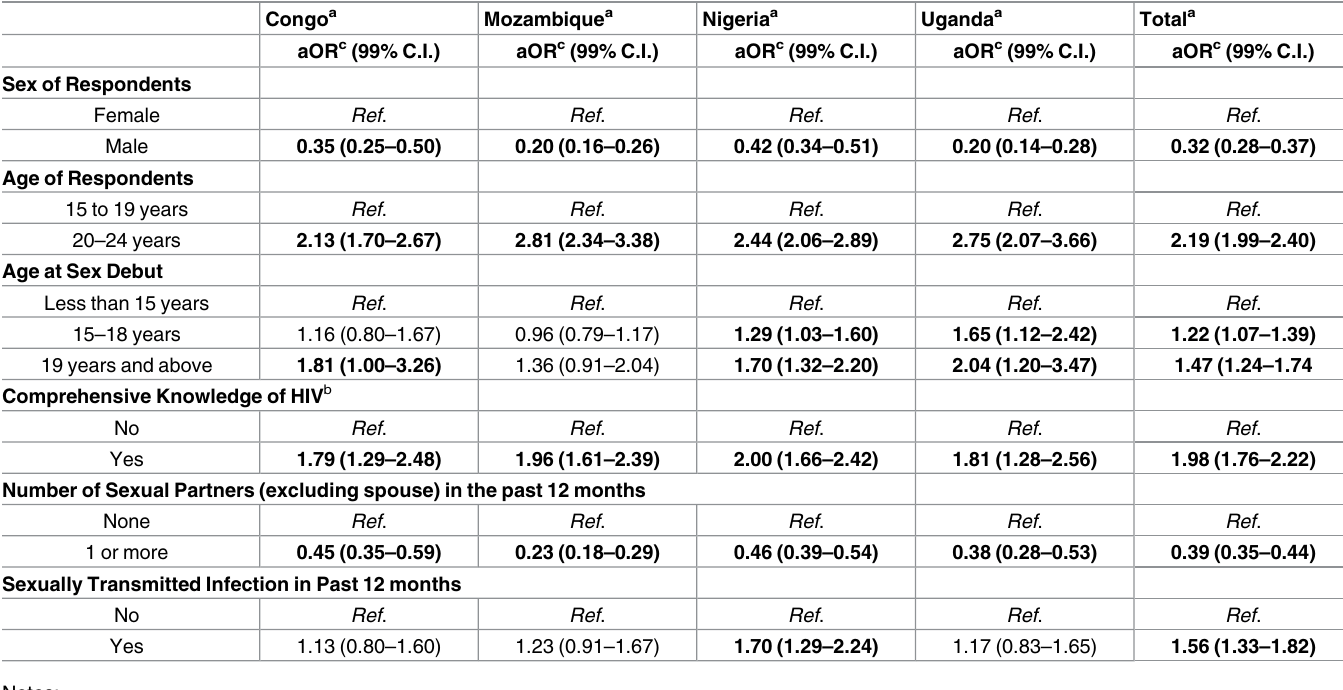
Table 3. Logistic Regression Models HIV testing by Participants’ Demographic and Reproductive Health